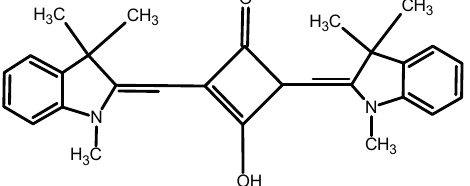
Scheme 1. Structures of squarine